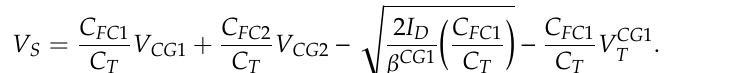
Table 1. The design parameters of the device.